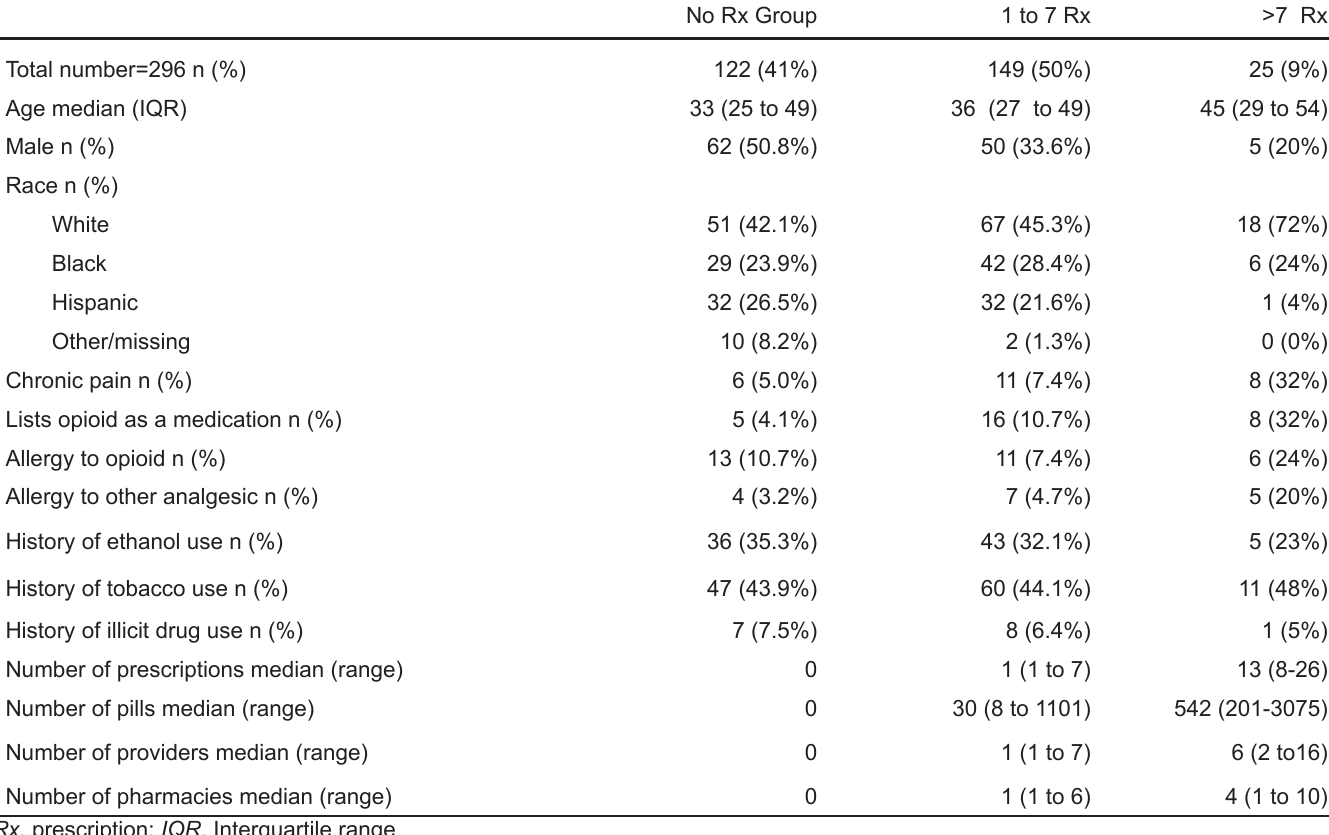
Table 2. Characteristics of patients with zero opioid prescription in the last 6 months, the highest decile (>7 Rx) for number of prescriptions in the 6 months preceding their ED visit and all other patients in the study group (1 to 7 Rx).